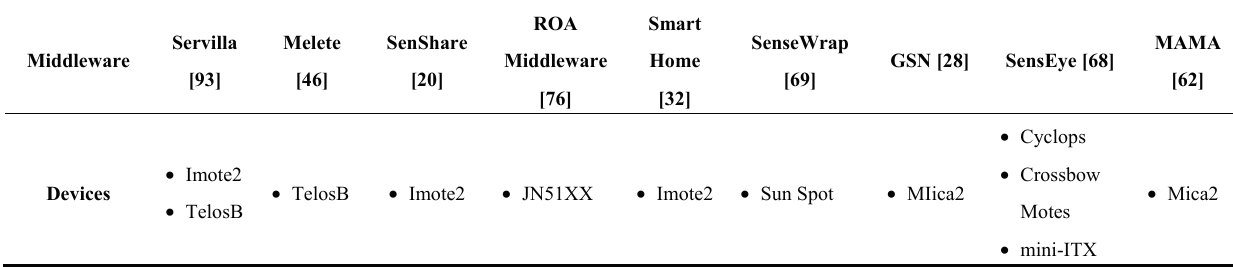
Table 2. Middleware and devices used for